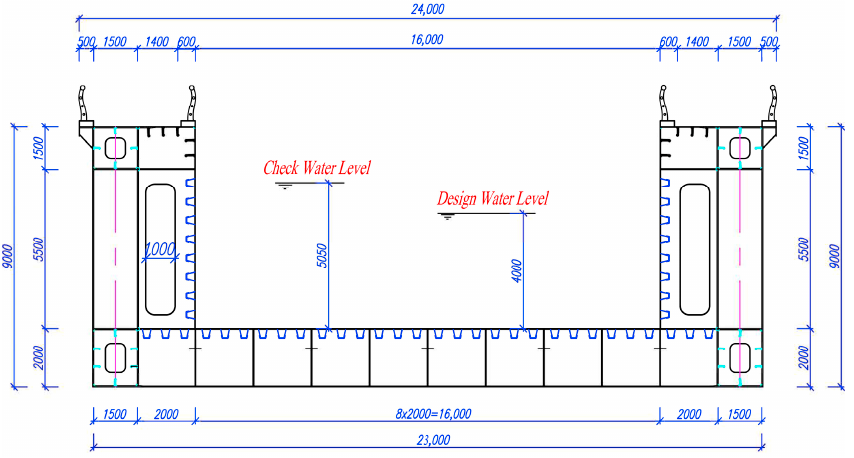
Figure 3. Cross-section in mid-span of the aqueduct.